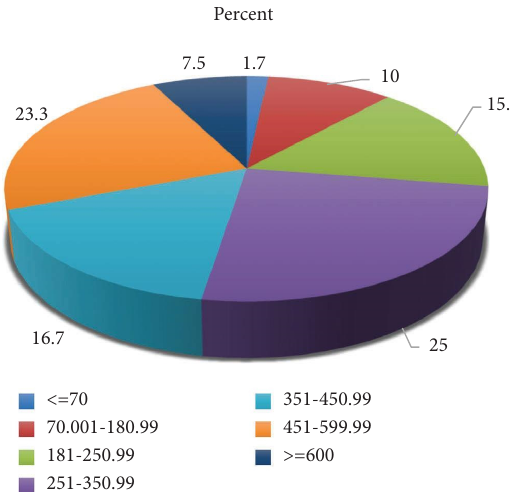
Figure 2: Admission blood glucose (RBS) level among patients with DM admitted to JMC from October 01, 2020, to June 30, 2021.